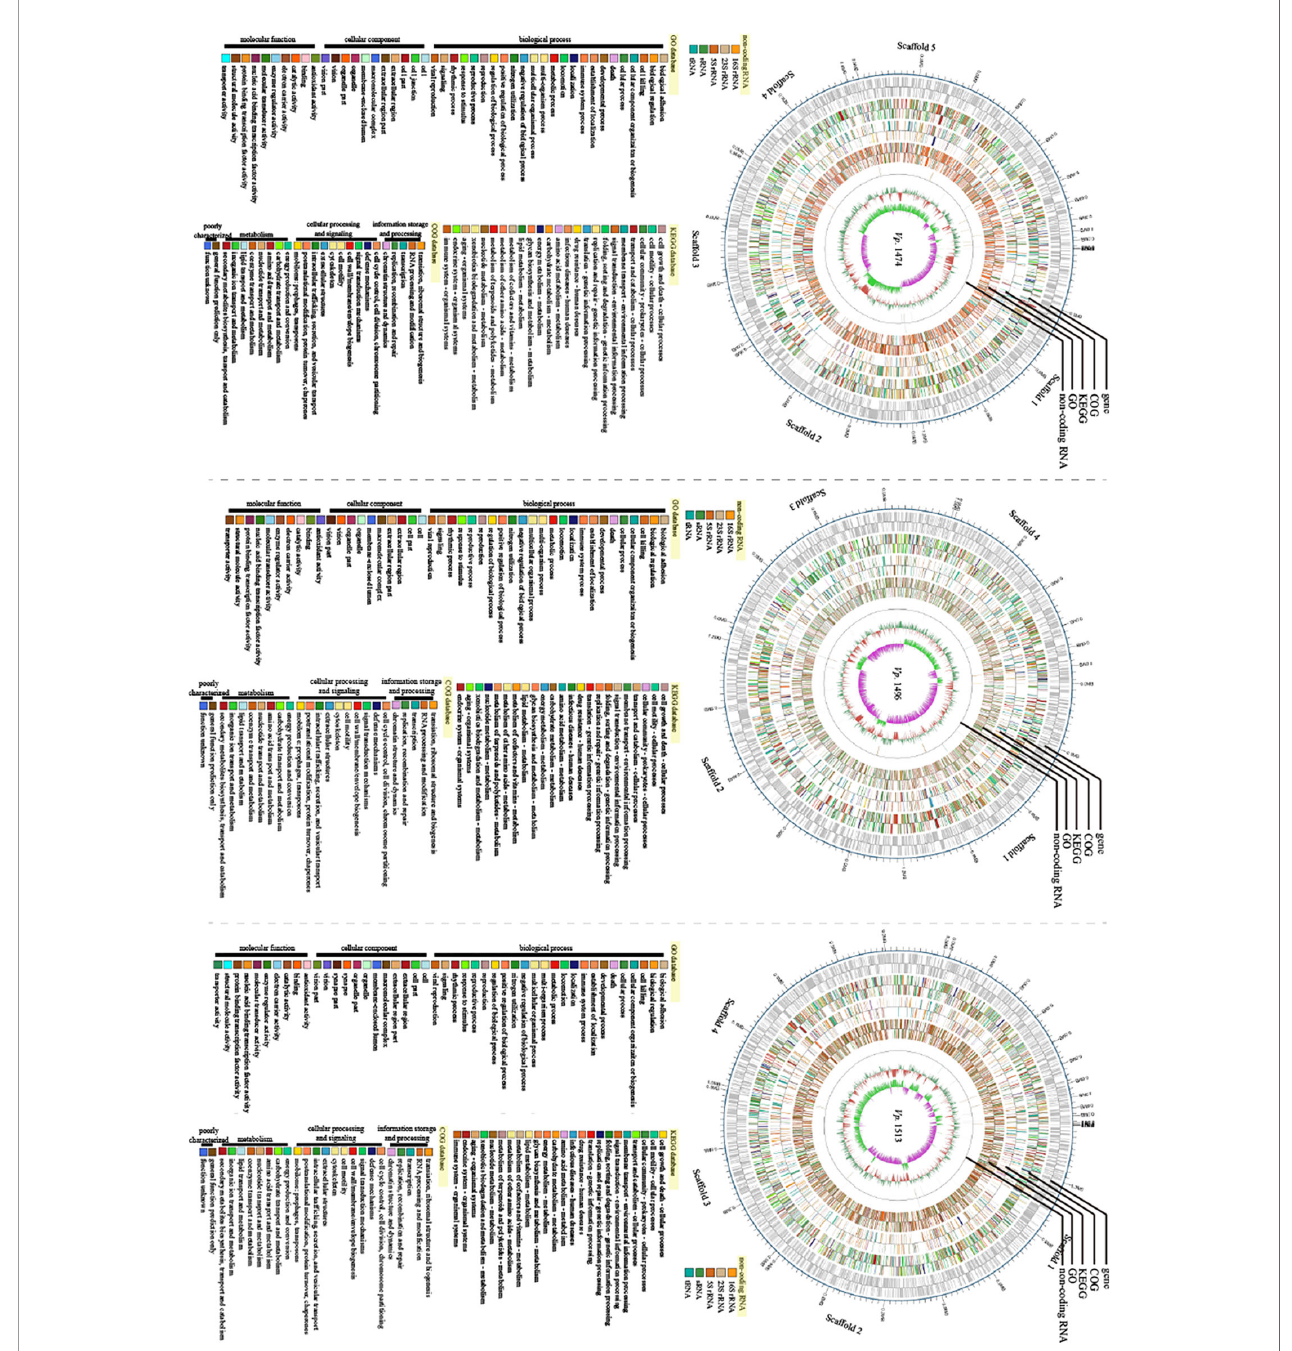
FIGURE 7 | Genomic visualization analysis of V. parahaemolyticus strains Vp . 1474, Vp . 1496, and Vp . 1513. Three genome-wide maps represented the combination of the prediction results of the coding genes. Results of gene distribution analysis, COG classi fi cation, KEGG pathway, GO annotation, and non-coding RNA are presented from the outermost to innermost